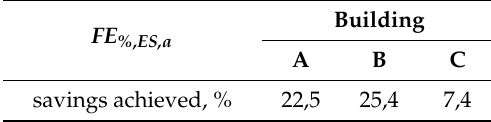
Table 5. Energy savings achieved through thermal improvement of buildings.